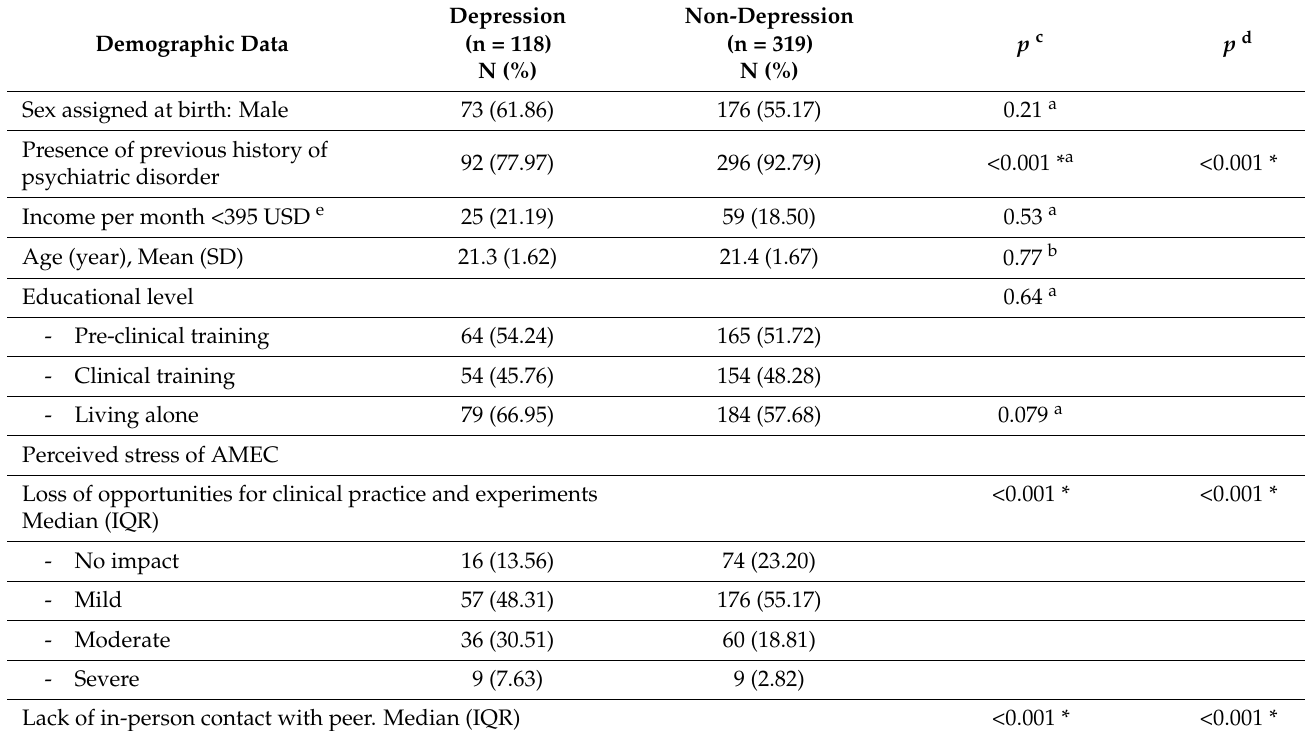
Table 1. The comparative data between clinically significant depressed and non-depressed groups in sociodemographic data, perceived stress of AMEC, and resilience